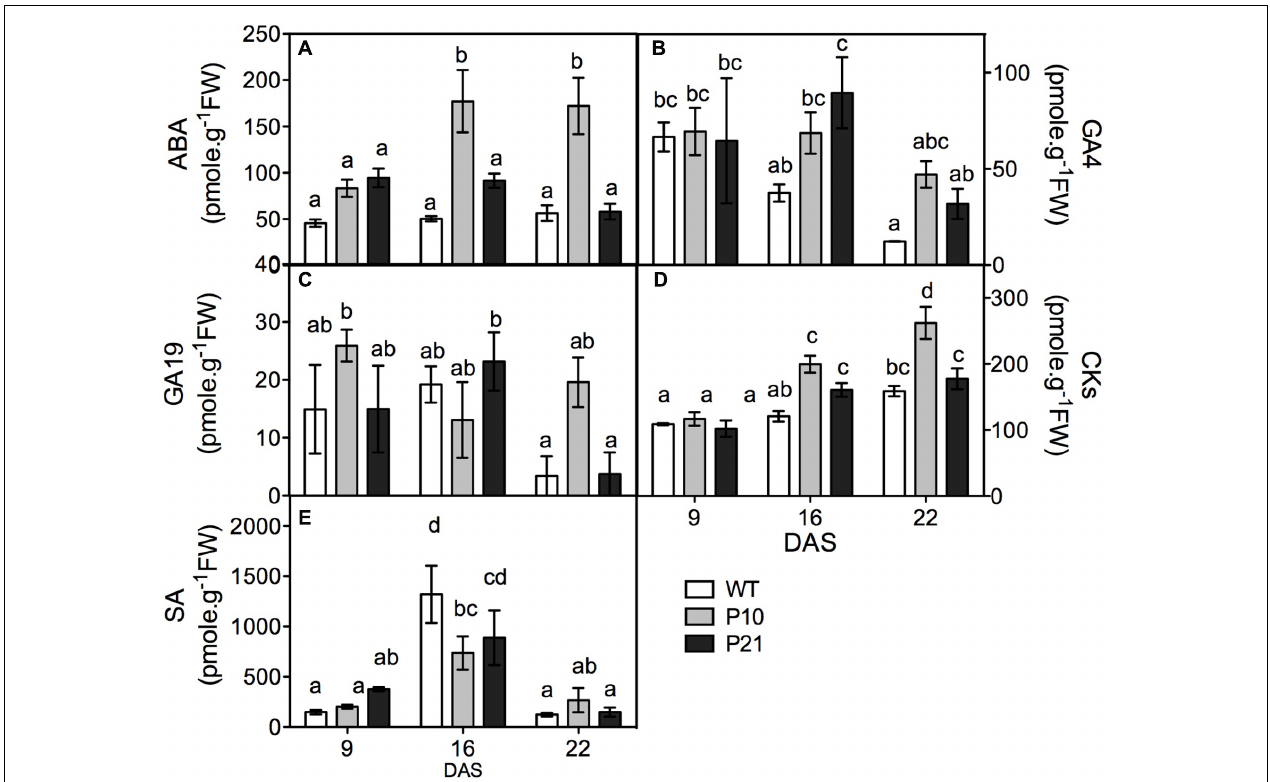
FIGURE 3 | Hormone quantification in the rosettes of WT and PID overexpression lines at different time points. Abscisic acid (ABA; A ). Gibberellic acid (GA4 and GA19; B,C ). Cytokinins (CKs; D ) and salicylic acid (SA; E ). Different letters in the graph represent significant differences between genotypes and time. (Duncan test; P < 0.05; n = 3; Error bars: ±